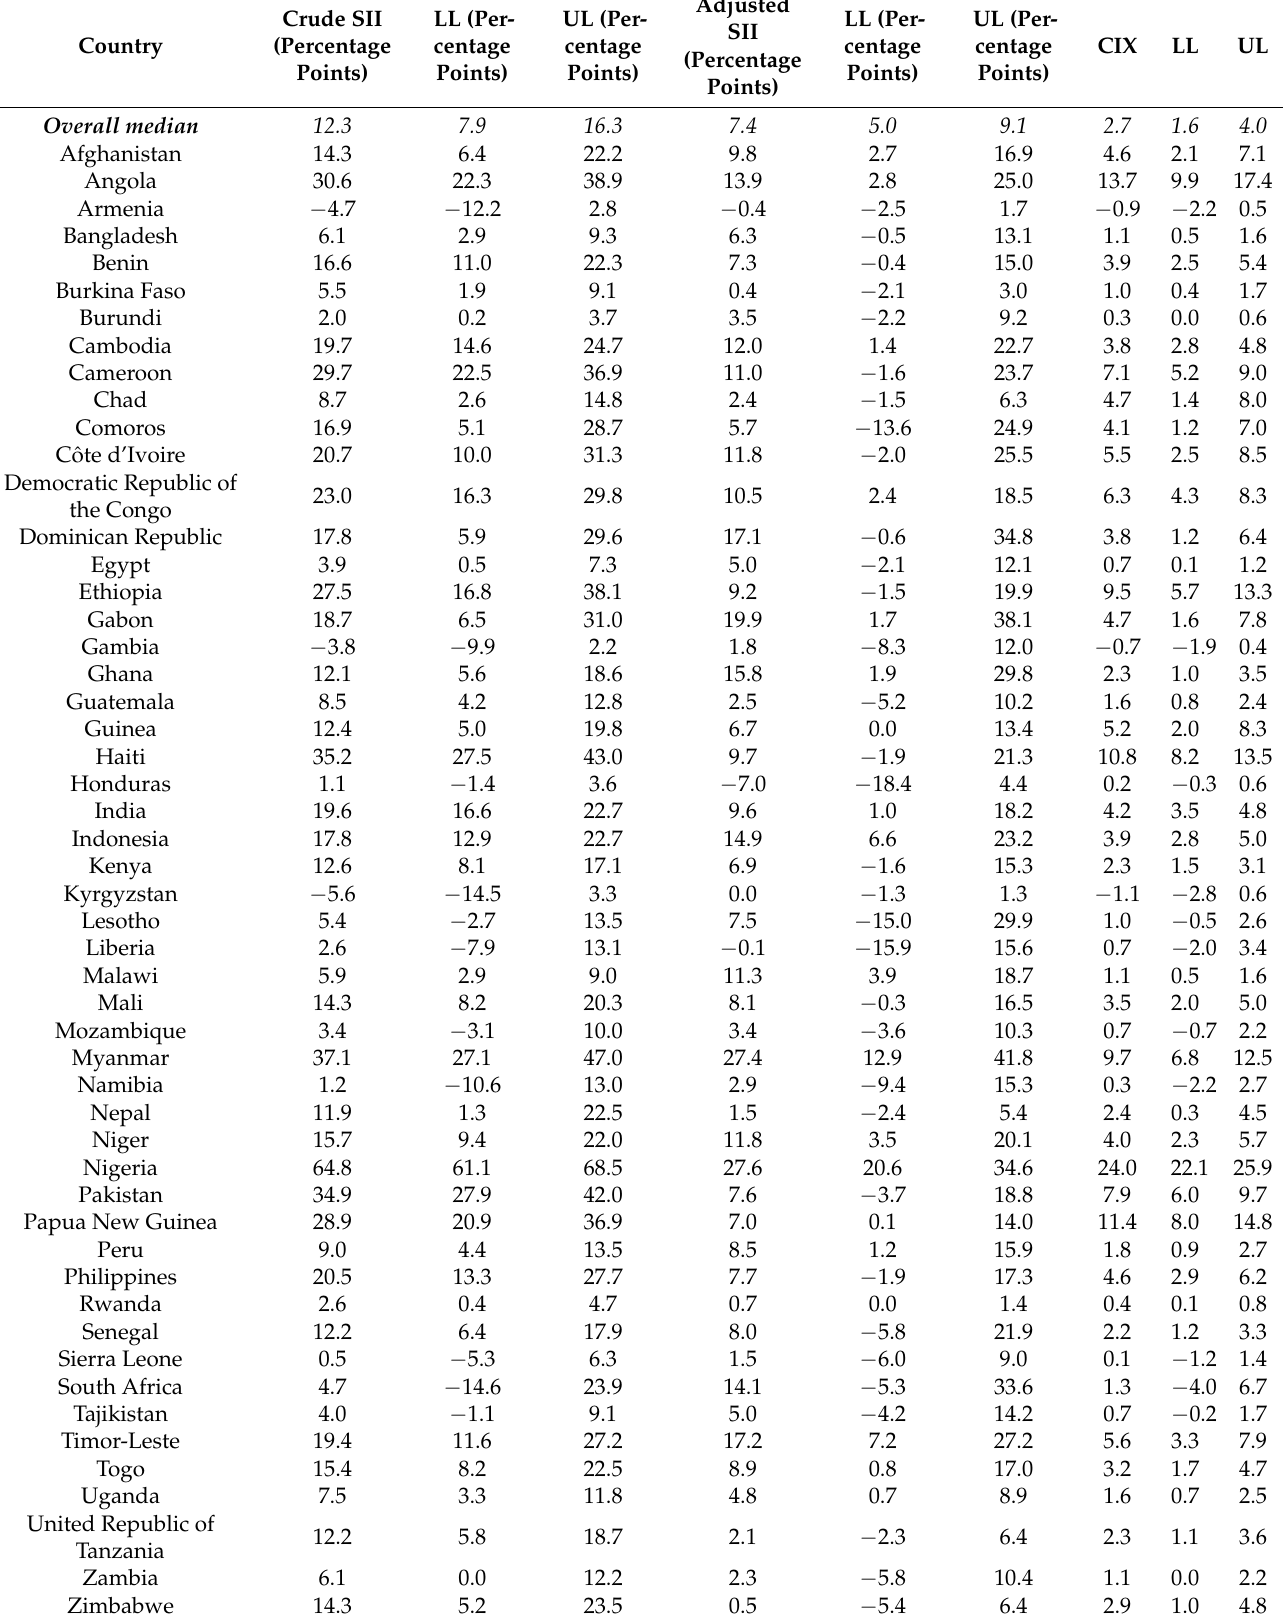
Table 2. Measures of inequality in DTP3 coverage by SWPER Global Index social independence domain, children age 12–35 months in 52